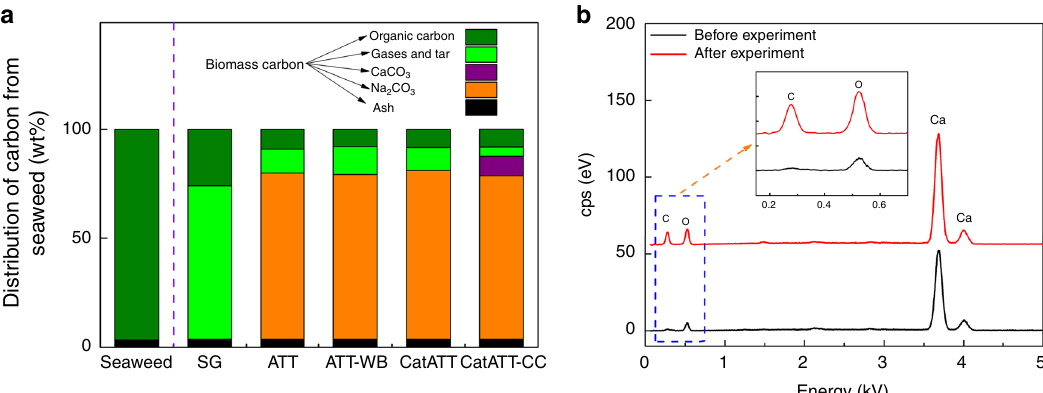
Fig. 3 Fixation of seaweed carbon into solid carbonates. a Distribution of carbon from seaweed in different product streams illustrating the fate of carbon during the ATT reaction. Thermodynamically stable solid carbonates (red and orange) make up the most of the carbon fraction for CatATT-CC. b SEM-EDS of Ca(OH) 2 before and after the CatATT-CC reaction con fi rming in situ